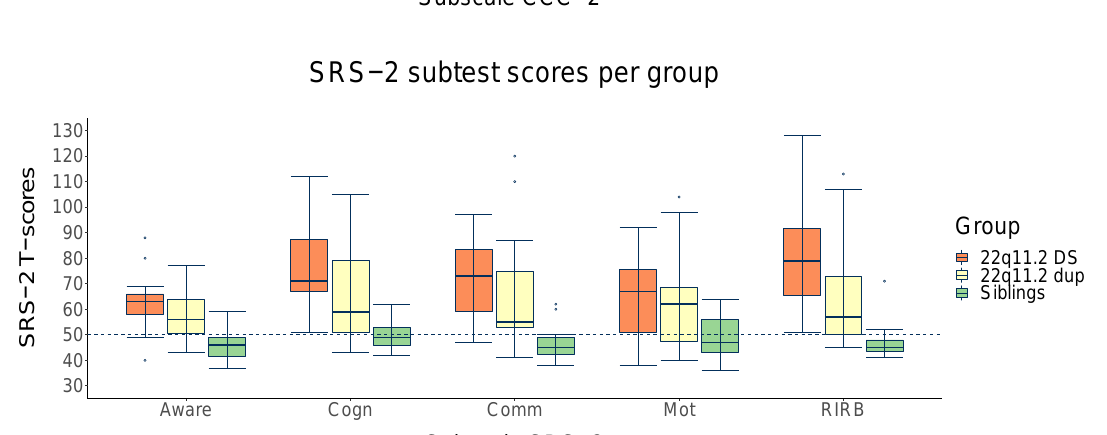
problems; the darker the gray, the more severe the difficulties: mild–moderate = light gray zone and